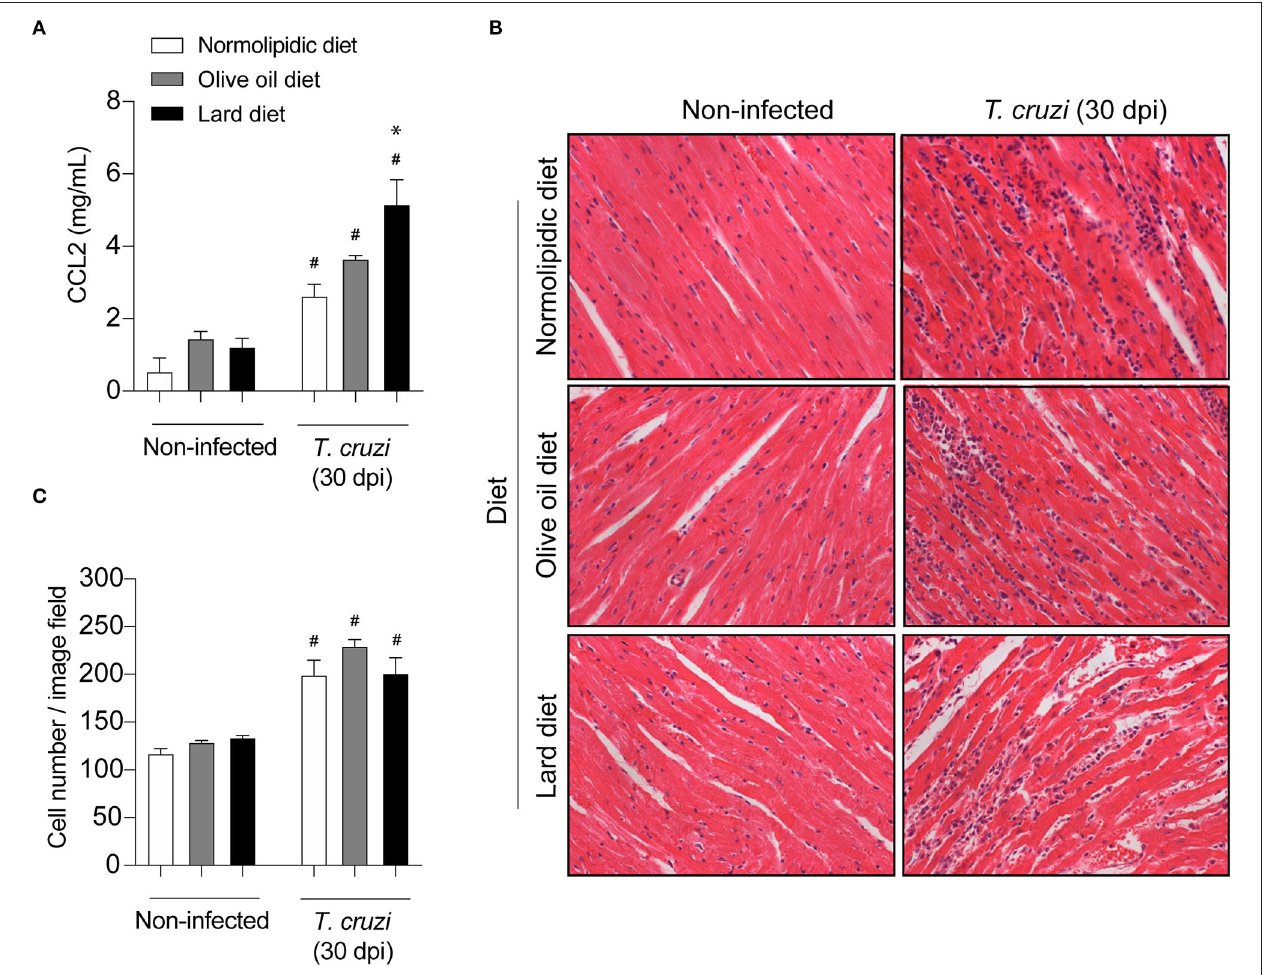
FIGURE 3 | Cardiac inflammatory parameters of T. cruzi infected mice fed with different types of hyperlipidic diets. Newly weaned C57BL/6 mice were fed with either a normolipidic diet ( n = 8), monounsaturated fatty acid diet with olive oil ( n = 8) or saturated fatty acid diet with lard ( n = 8). At the day 60 of diet, mice were intraperitoneally infected with 50 blood trypomastigote forms of T. cruzi Colombian strain. After 30 dpi (A) the concentration of CCL2 was assessed in the heart tissue by ELISA assay. (B) The heart tissue was fixed, processed, blocked in paraffin, cut, and stained with hematoxylin and eosin and (C) the number of cells in the tissue was quantified. # p < 0.05 compared with the non-infected group and * p < 0.05 compared with infected normolipidic diet group by one-way ANOVA followed by Tukey post-hoc